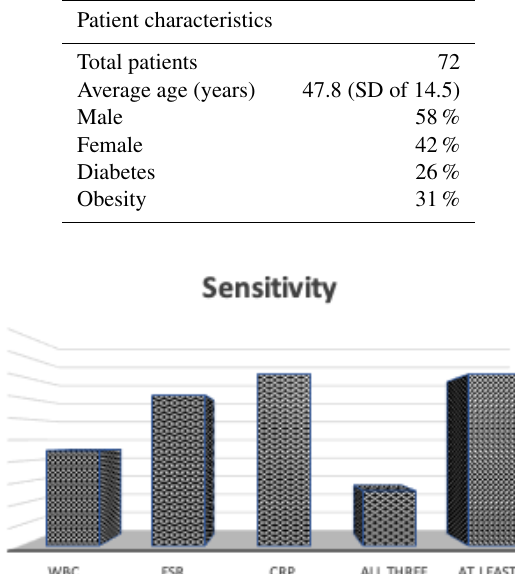
for obesity at ≥ 30 ( n = 25), the sensitivity of all markers positive was 0.17 and the specificity was 1.0. Sensitivities of WBC, ESR, and CRP for obese patients were 0.43, 0.72, and 0.85; specificities were 1.0, 1.0, and